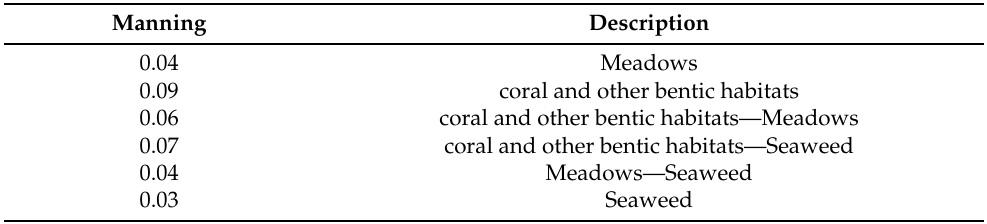
Table 2. Table of Manning coefficients for coastal shallow water according to classification by Chauvaud et al.